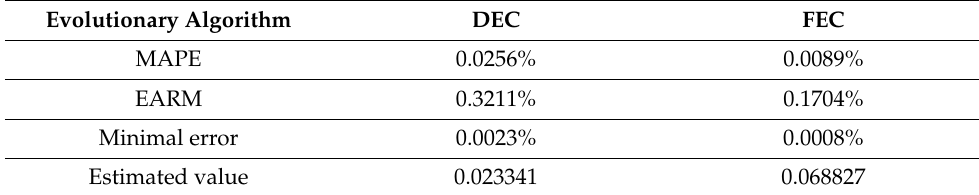
Table 5. Result of the proposed methodology for DEC and FEC.